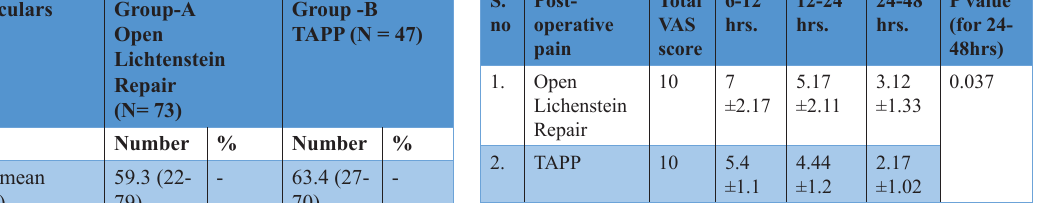
Table 3. Post- operative pain compared with VAS score among patients who underwent hernia repair S. Post- no operative